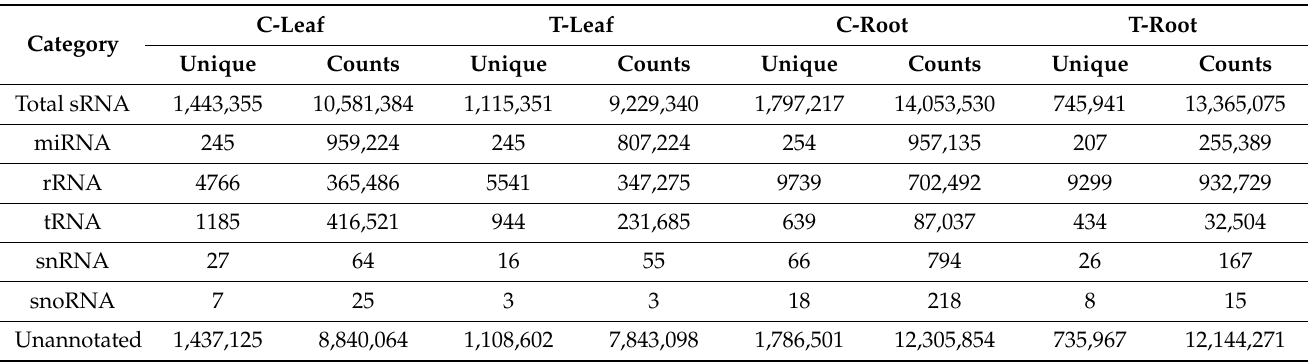
Table 3. The distribution of small RNAs among different categories in the leaves’ and roots’